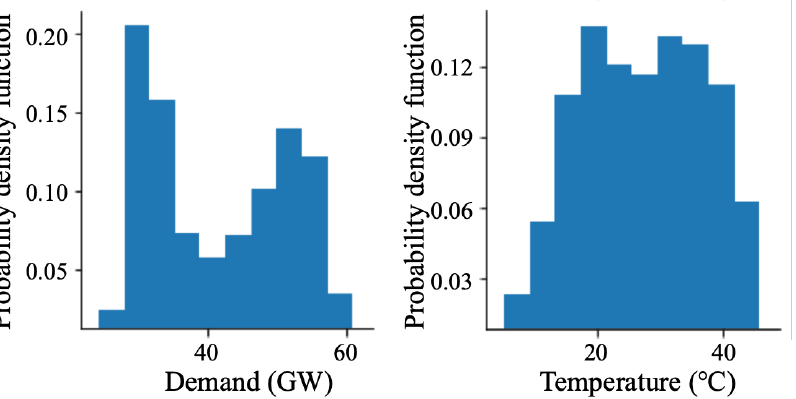
Figure A2. Probability density function of the electricity demand of KSA and the temperature data of Riyadh city for